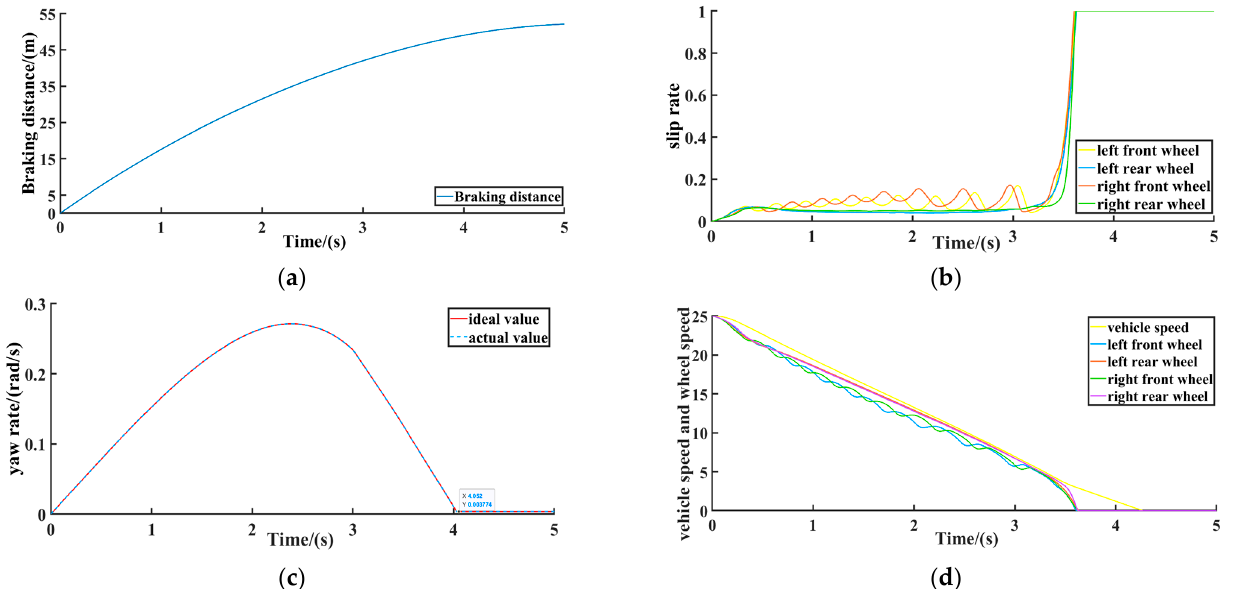
Figure 9. Vehicles driving in off-road conditions. ( a ) Wheel braking distance. ( b ) Slip rate of four wheels. ( c ) Vehicle yaw rate. ( d ) Vehicle speed and speed of four wheel.